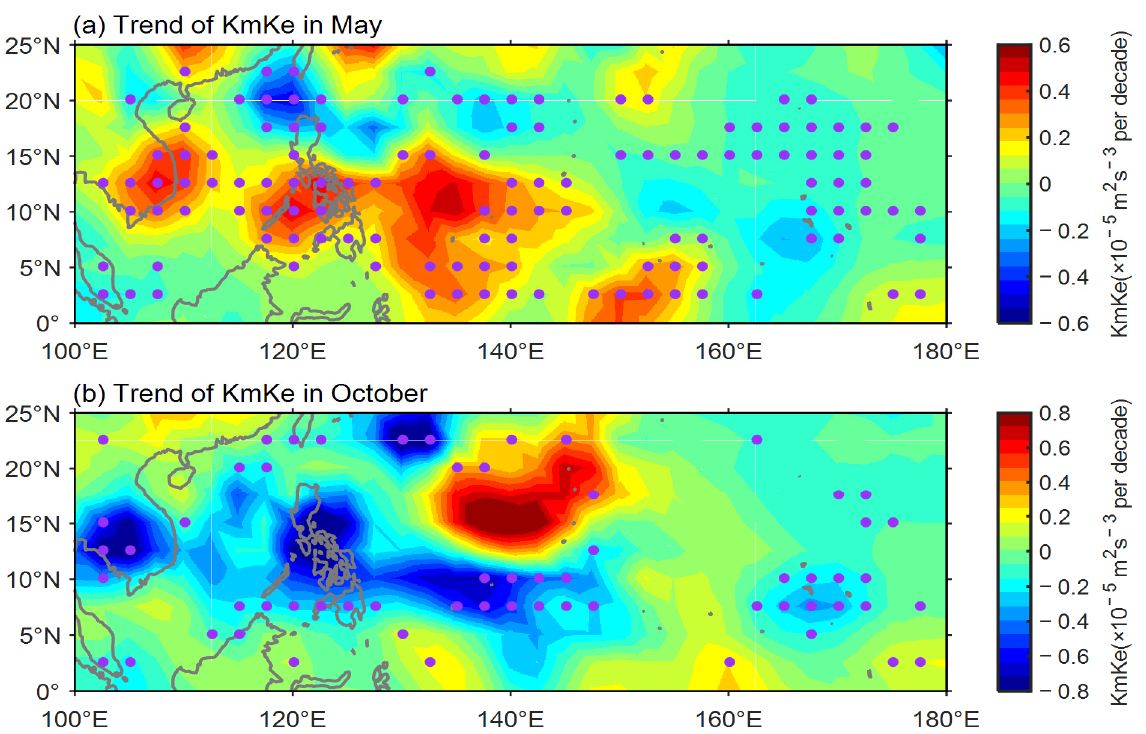
Figure 6. Spatial distribution of linear trends of BEC term (KmKe) (shading) in ( a ) May and ( b ) October. Signals above the 90% confidence level are highlighted by purple dots.